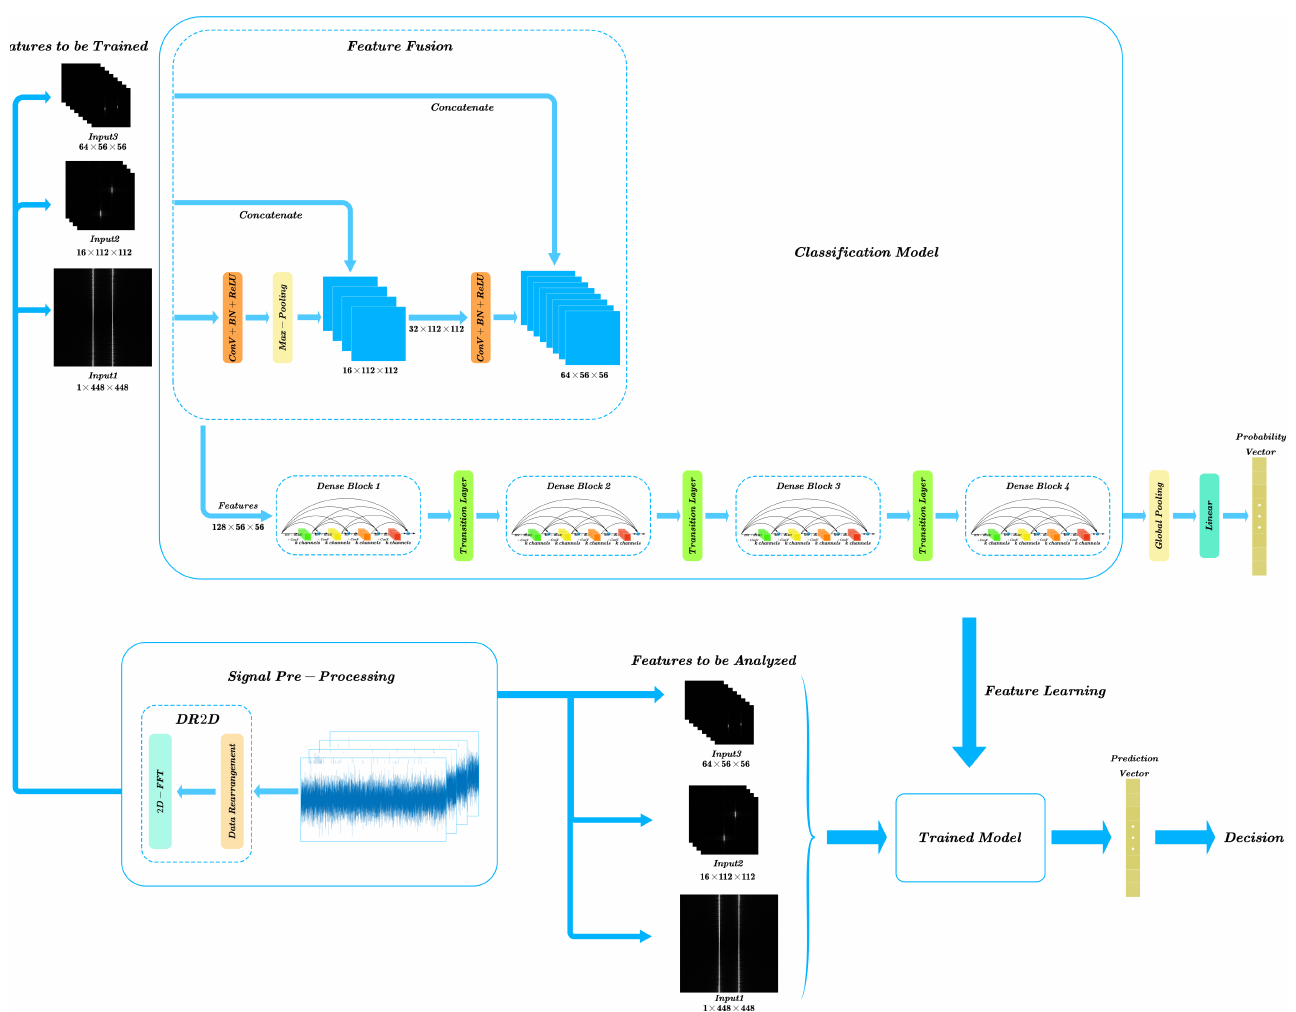
Figure 7. Feature recognition process of the DenseNet feature extraction network with early